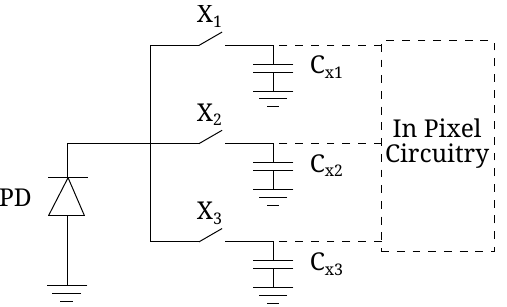
Figure 5. Schematic of a current mode pixel for 1B